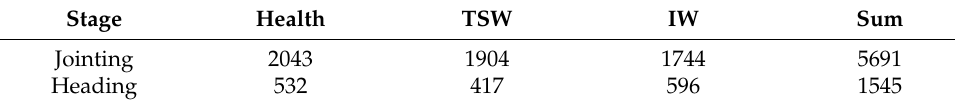
Figure 4. Classing: Four categories, two stages. Table 3. Number of processed (Condition 1): Healthy leaves: Green healthy leaves, complete without damage.